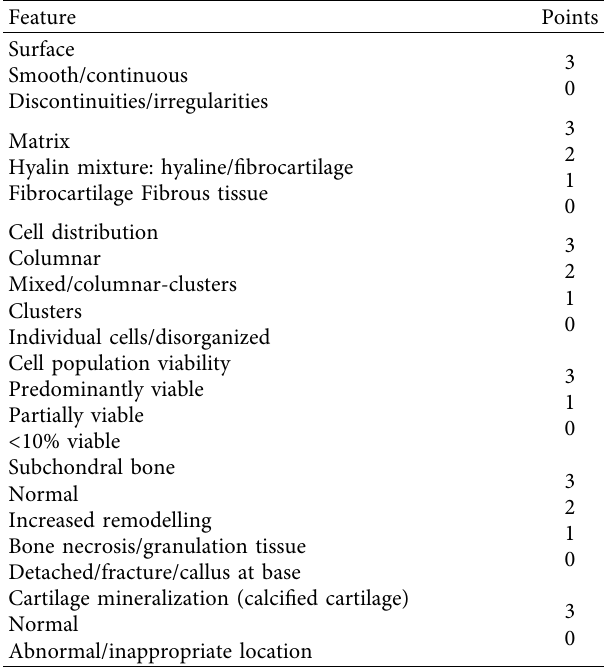
Table 2: ICRS (International Cartilage Research Society) Visual Histological Assessment